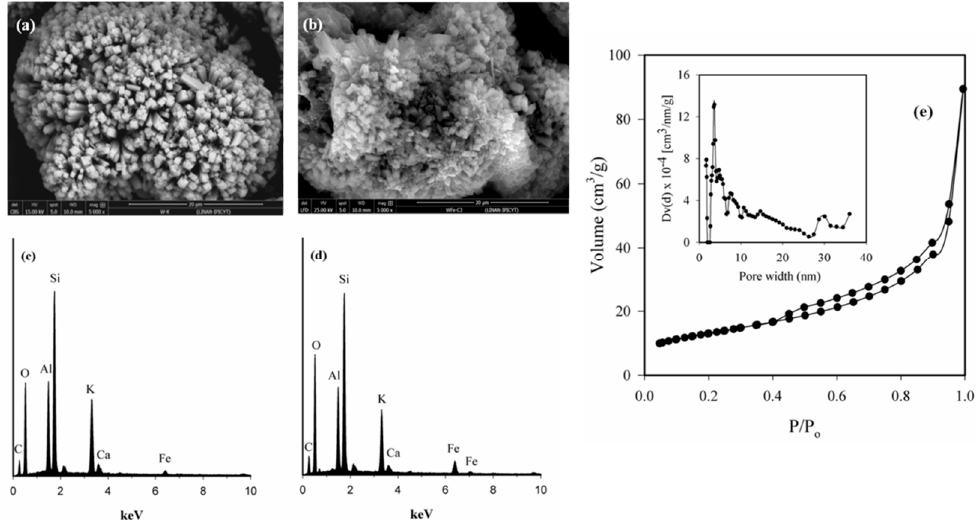
Figure 2. SEM micrographs and EDS spectra of ( a , c ) the pristine zeolite and ( b , d ) Fe-modified W zeolite, ( e ) nitrogen adsorption isotherm and pore size distribution (inset) of the Fe-modified W zeolite.